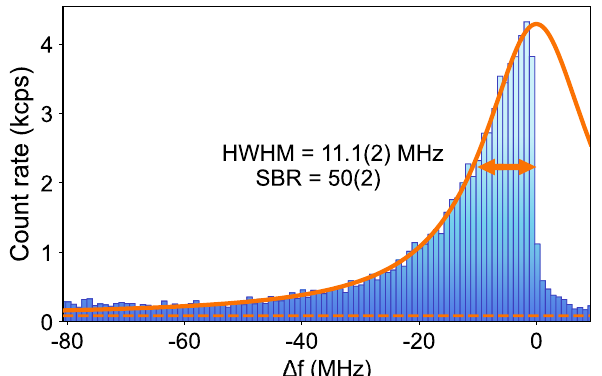
Figure 3. Unsaturated cooling transition spectral profile measured at 0.14 µ W . The orange solid line is a Lorentzian fit to the red-detuned data, showing a fitted linewidth close to the natural linewidth of the 40 Ca + cooling transition. The dashed orange line shows the count rate measured without an ion in the trap, i.e. the background scattering count